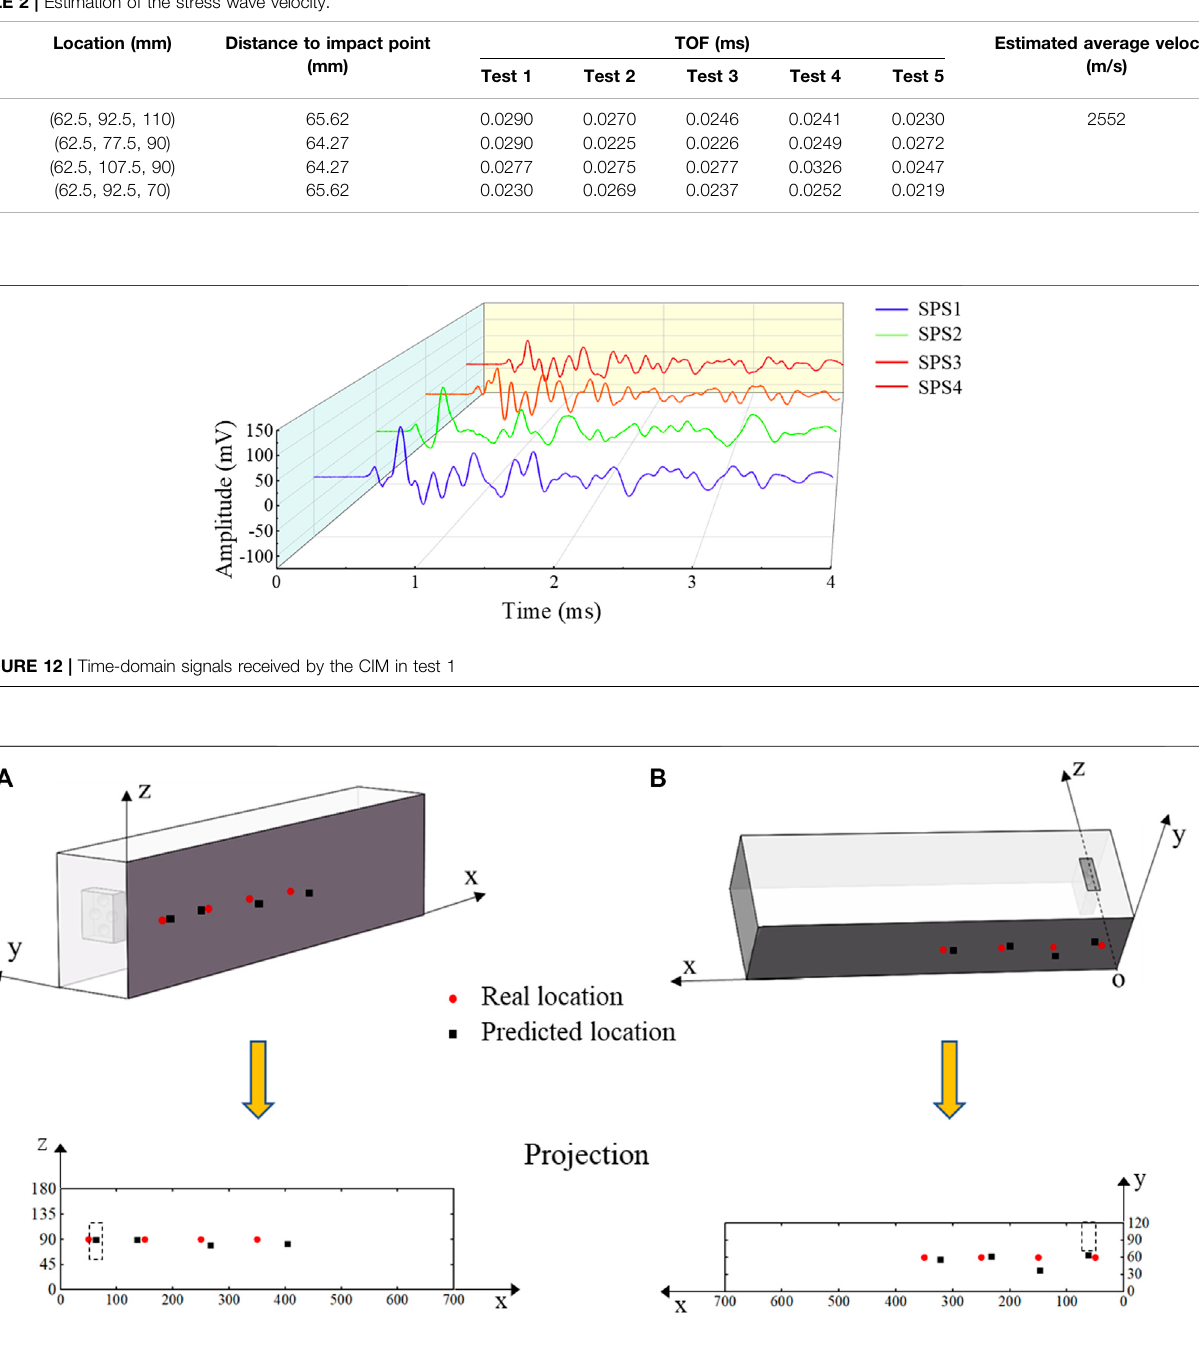
Frontiers in Materials |